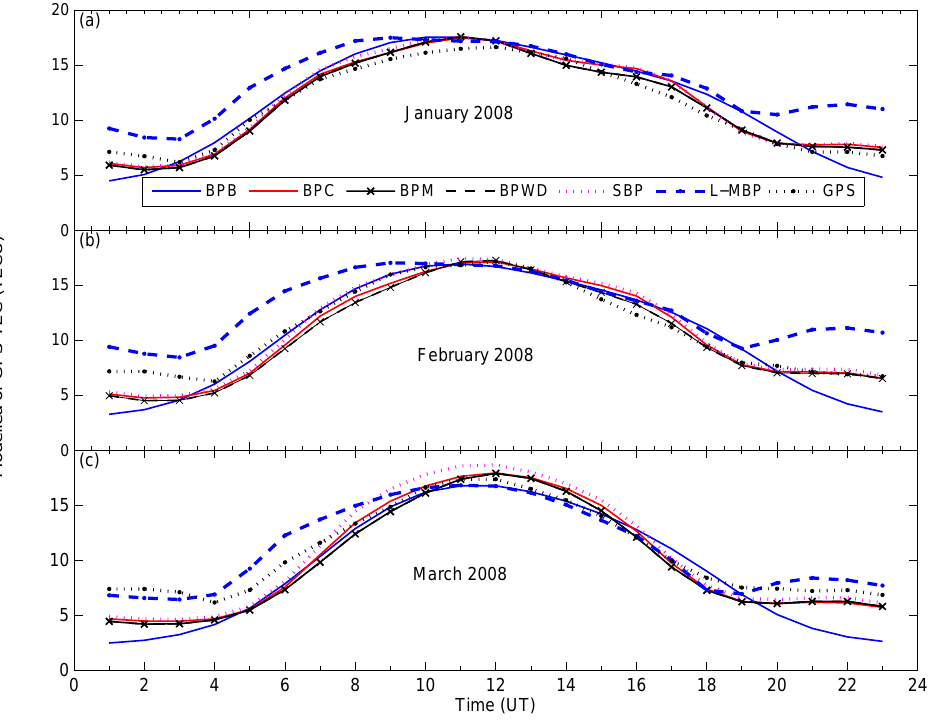
Fig. 6. Hourly average modelled and GPS TEC values for January, February and March 2008 over SUTH.